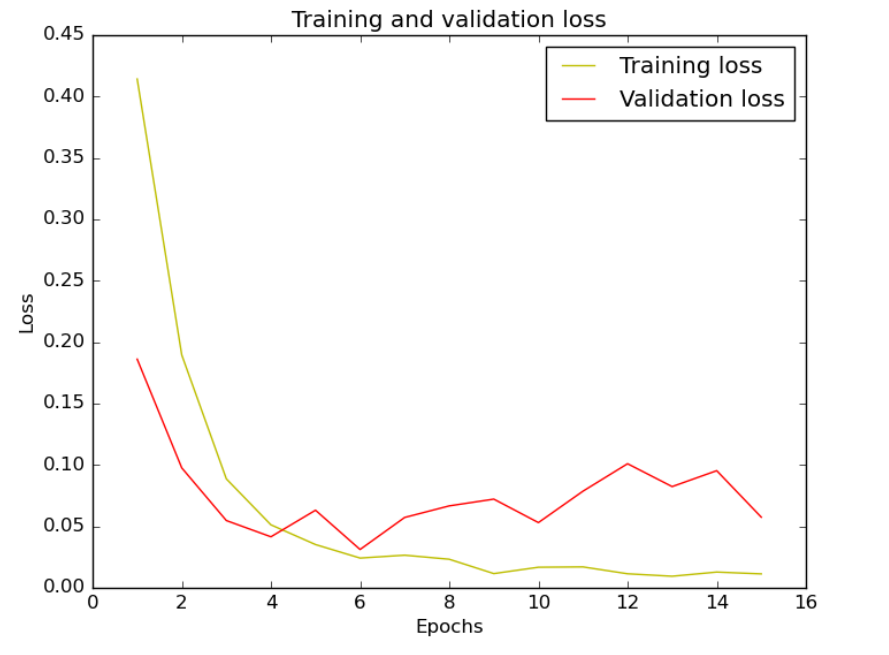
Figure 12. Training and validation loss plot for the binary classification